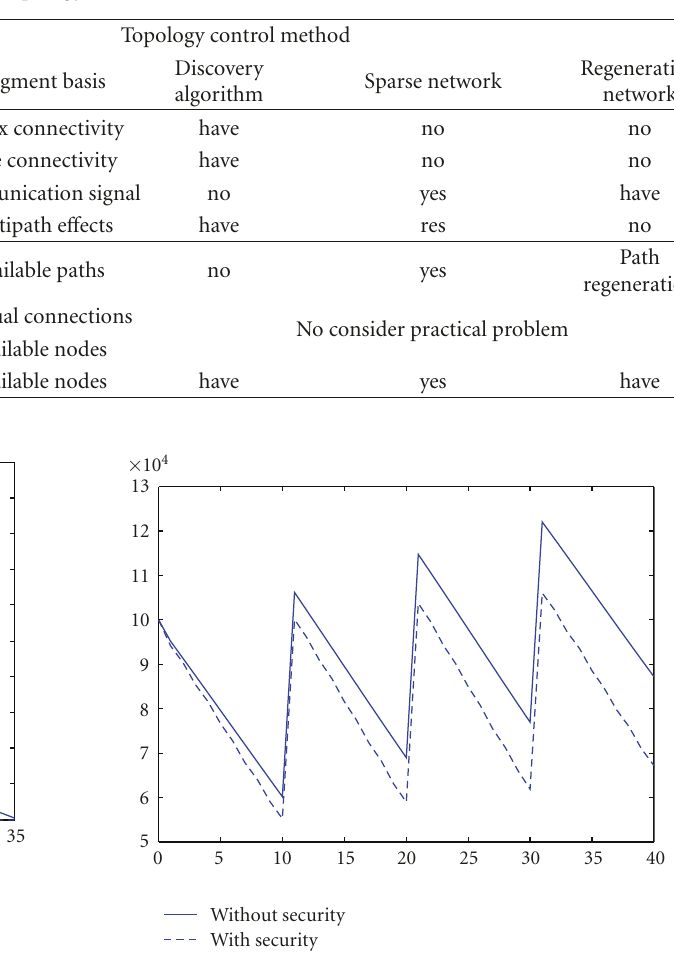
Table 2: Topology control method.